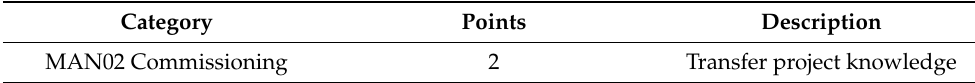
Table 7. Project scorecard Nurses Residence—Management